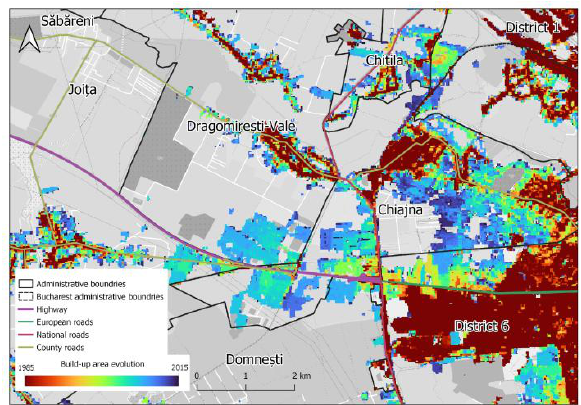
Figure 14 . Urban expansion of Bucharest between 1985 and 2015 - West (data source: WSF Evolution, DLR, CC-BY 4.0; base map: © OpenStreetMap